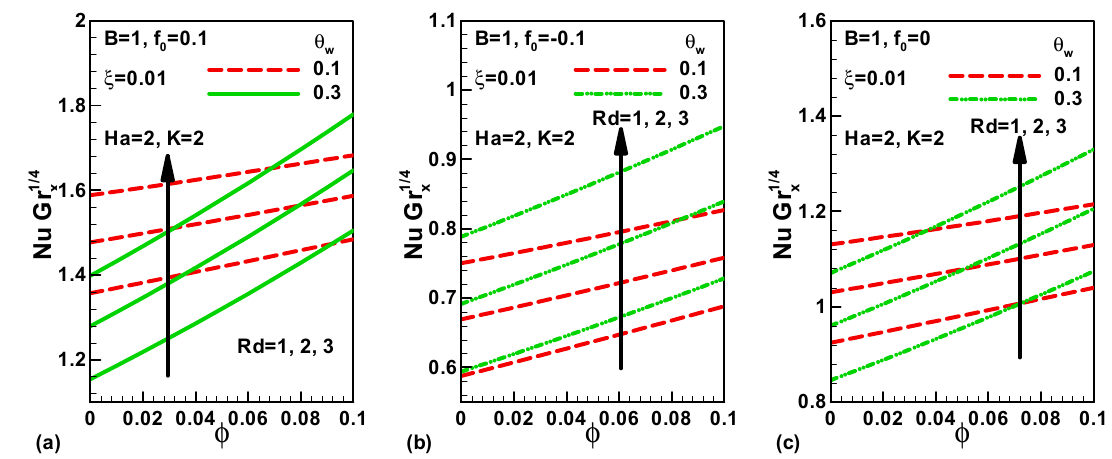
Figure 11. Variation of Nusselt number with solid volume fraction of nanoparticles, radiation, and wall temperature parameters along truncated cone for ( a ) suction, ( b ) injection, and ( c ) impermeable of kerosene-based magnetite nanofluid.